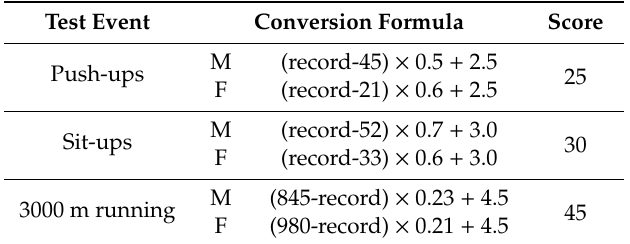
Table 2. Scoring and conversion formula for military fitness